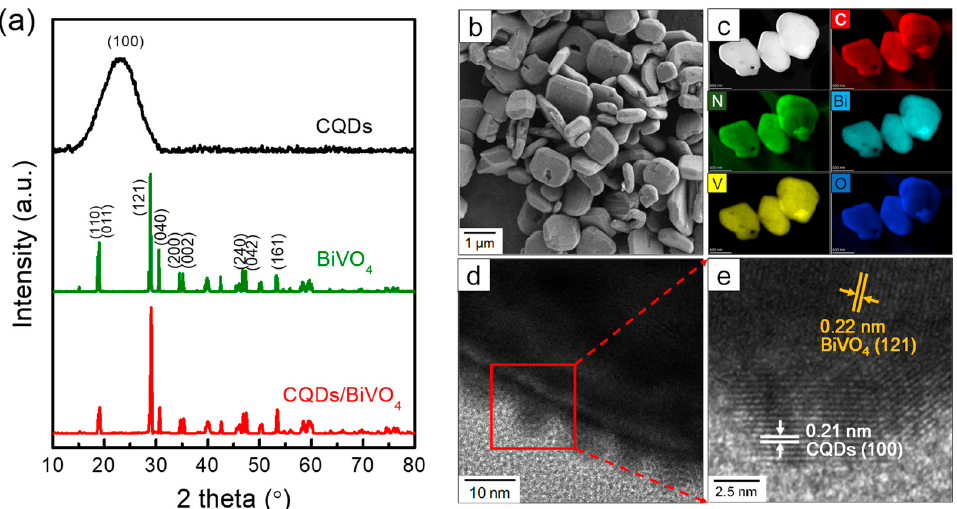
Figure 1. ( a ) XRD diffraction patterns of CQDs, BiVO 4 , and 0.6%CQDs/BiVO 4 . ( b ) FESEM image of 0.6%CQDs/BiVO 4 . ( c ) TEM elemental mapping images of C, N, Bi, V and O; ( d ) HRTEM images of 0.6%CQDs/BiVO 4 and ( e ) the magnified image of selected area in ( d ). Fourier transform infrared spectrascopy (FTIR) and Raman spectra were further recorded to clarify the constitution of the materials. As shown in Figure 2a, the IR spectrum of CQDs presented stretching vibrations at 3452 (O-H), 3246 (N-H), 2924 (C-H), 1655 (C=O), 1546 (C=N), and 1048 (C-O-C) cm − 1 , while the peak centered at 1386 cm − 1 was identified as the stretching vibration of C-N [26]. The IR peaks of BiVO 4 located at 746 and 810 cm − 1 belonged to the symmetric and asymmetric stretching vibrations of VO 43- [27]. With respect to the IR spectrum of CQDs/BiVO 4 , the peaks for CQDs (1386 cm − 1 ) and BiVO 4 (746 cm − 1 ) both appeared, thus validating their combination. Raman spectra analysis illustrated that CQDs had only a broad peak at 760–2300 cm − 1 (Figure 2b), while the distinct D (disordered sp 2 carbon atoms) and G bands (conjugated sp 2 carbon atoms) were prominent in CQDs/BiVO 4 (inset of Figure 2b) [28]. The non-observed D or G band